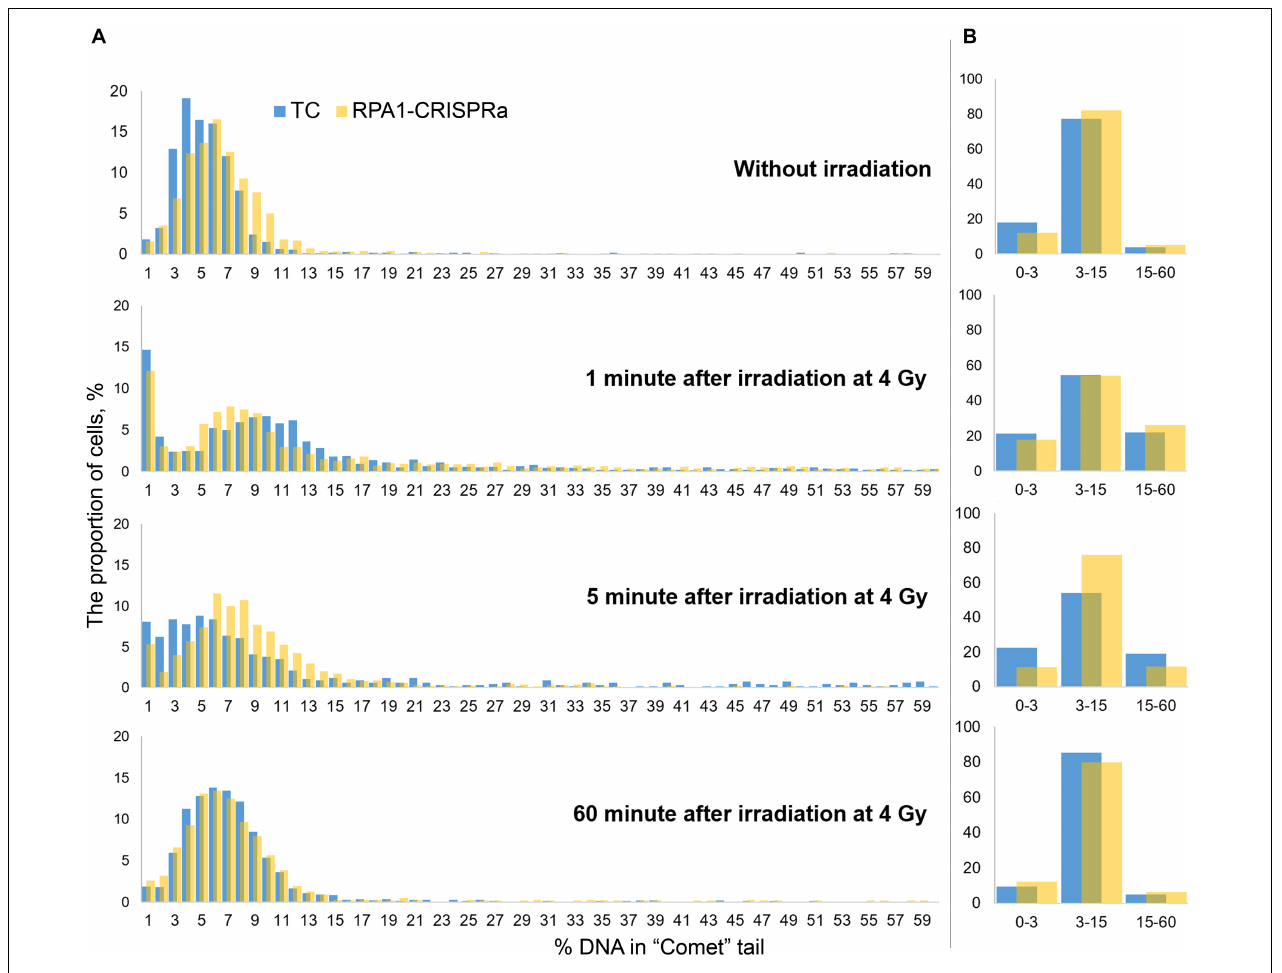
FIGURE 4 | Histograms of the distribution of DNA damage at various time points after irradiation. Cells were pooled either into 1% increments of %DNA in tail (A) for detailed histograms or into three categories of low (1–3 %DNA), intermediate (3–15 %DNA) and high (15–60 %DNA) level of electrophoretic mobility (B) . In (A) , all nucleoids were analyzed per group. The nucleoids with %DNA more than 60 were not used in the